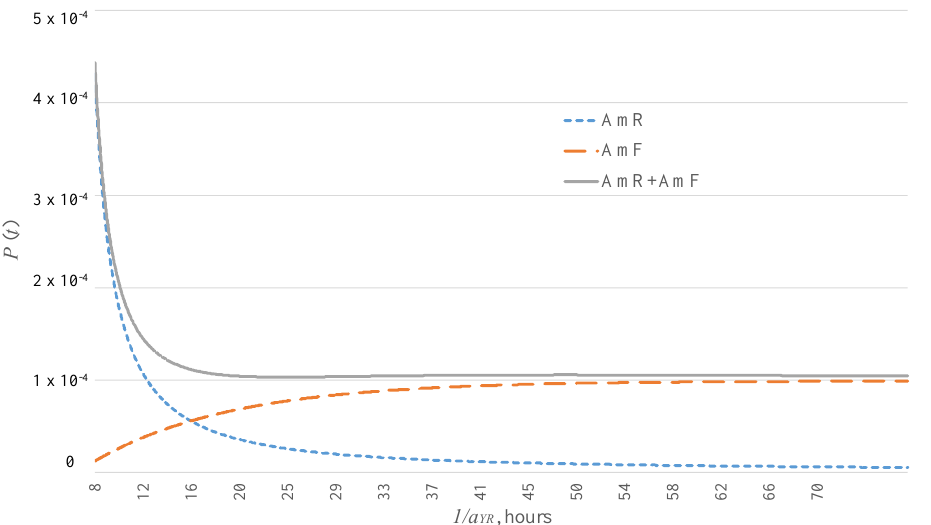
Figure 5. Results of the aging and rejuvenation process simulation using the original model not considering battery charge.